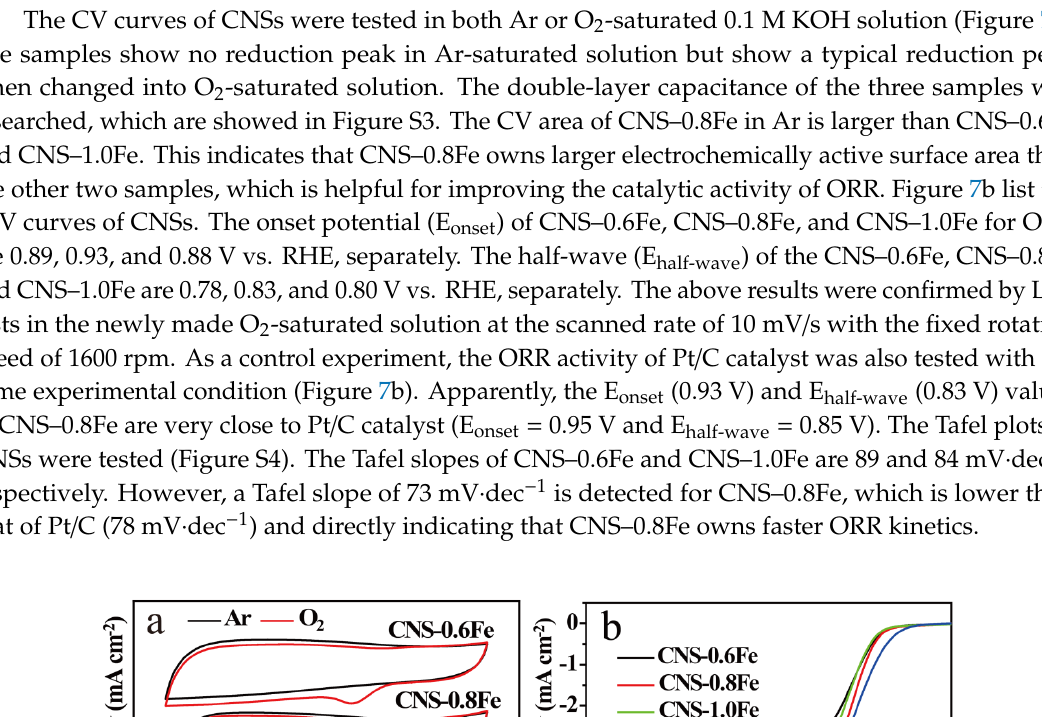
Figure 7. ( a ) CV curves of CNS – 0.6Fe, CNS – 0.8Fe and CNS – 1.0Fe in Ar or O 2 , scan rate: 50 V/s. ( b )